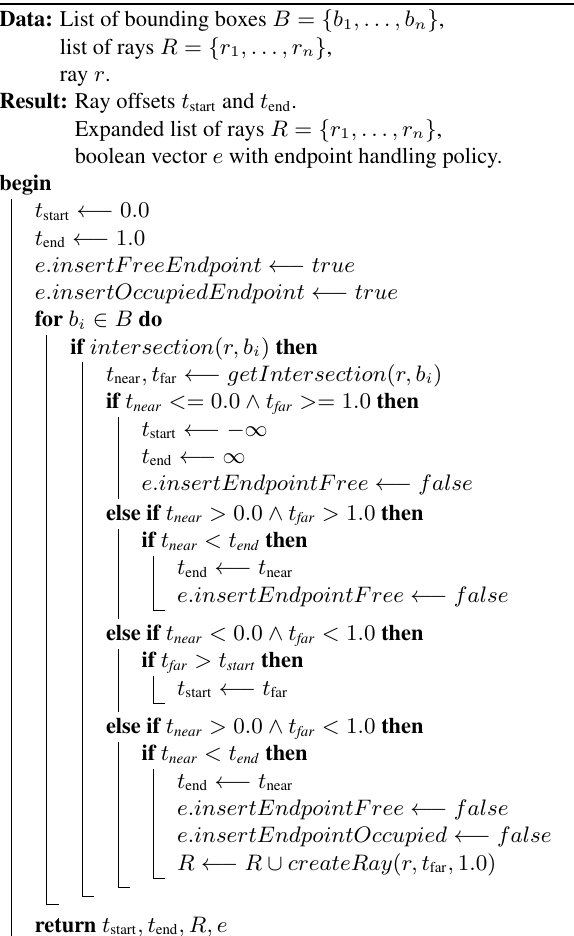
Algorithm 1: Overview of the plane-filtered raycasting algo- rithm.